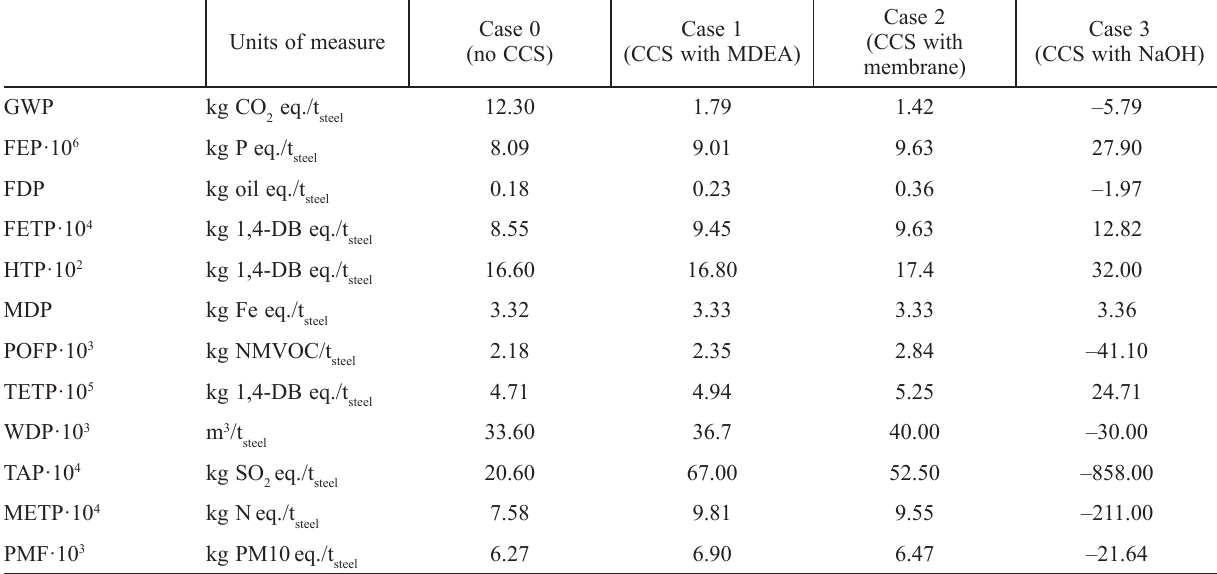
Table 7 – LCIA results according to ReCiPe impact assessment method Units of measure